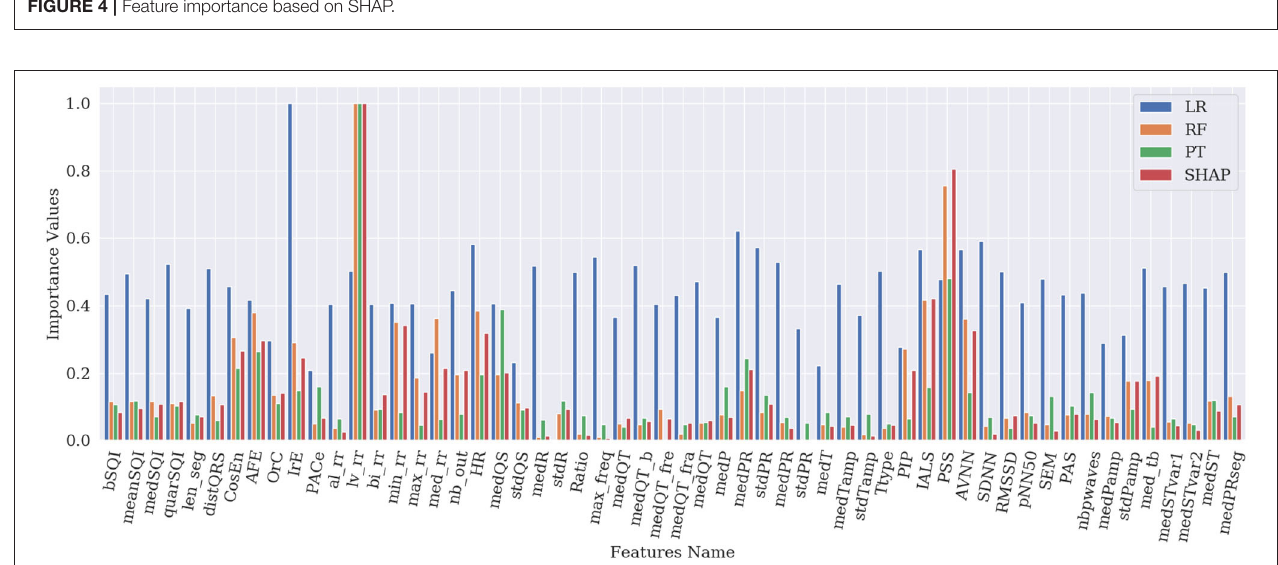
FIGURE 5 | Comparison of feature importance values obtained from different